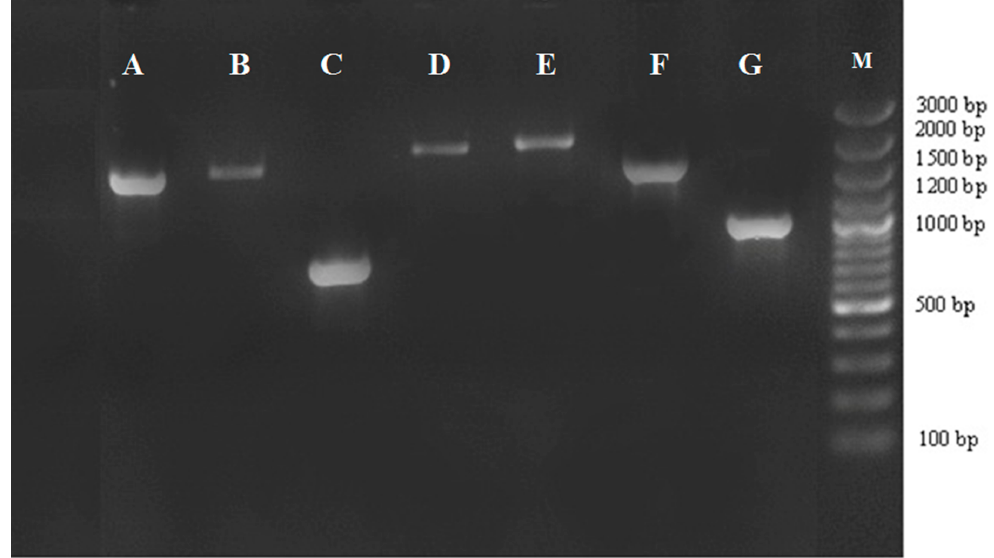
Figure 1. PCR amplification of gene cassettes in class 1 integrons. Bands with different sizes harbor different resistance genes. M: marker 100 bp; lane A–G: seven groups of class 1 integrons (A, dfrA1-orfC ; B, dfrA1-aadA1 ; C, dfrA15 ; D, dfrB4-catB3-aadA1 ; E, aac(6')-Ib-cr-arr3-dfrA27 ; F, dfrA12-orfF-aadA2 ; and G, dfrA12-aadA2 ).